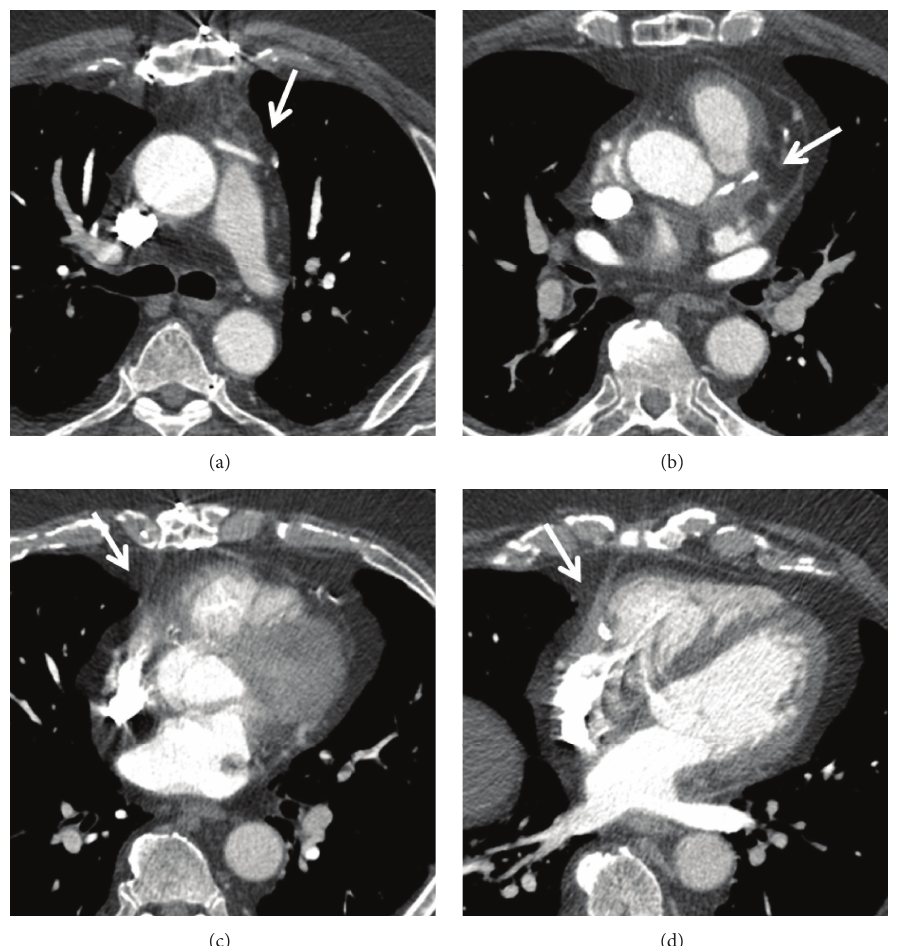
Figure 7: Contrast-enhanced computed tomography with subsequent images through the heart, in patient with granulomatosis with polyangiitis, shows resolution of soft tissue attenuation around the coronary artery graft (a), left main coronary artery (b), and right coronary artery (c, d) after the immunosuppressive